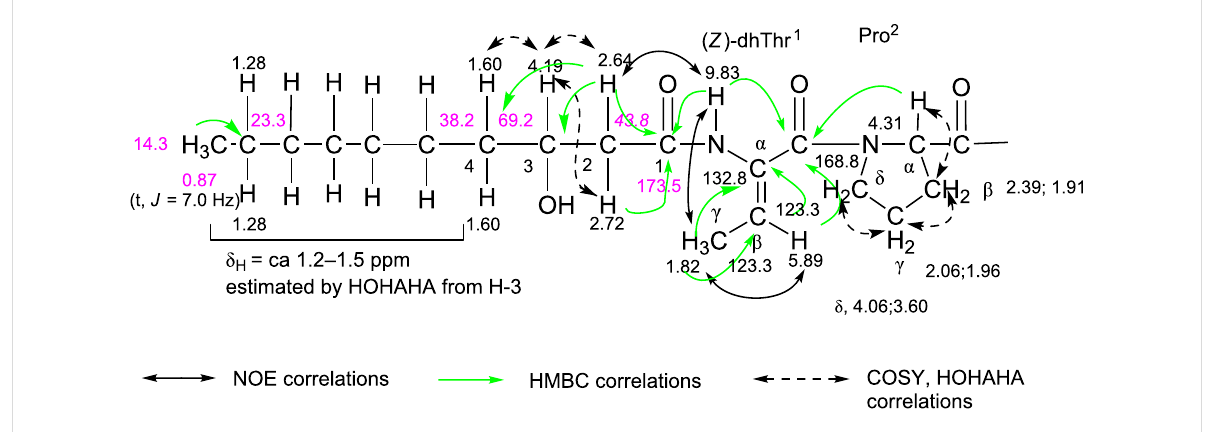
Figure 3: NMR analyses of the segment consisting of 3-hydroxydecanoyl-dehydrothreonin-proline (600 MHz, acetone- d 6 ). DhThr 1 and Pro 2 indicate that the first and second amino acids in the peptide backbone are dhThr and Pro, respectively.